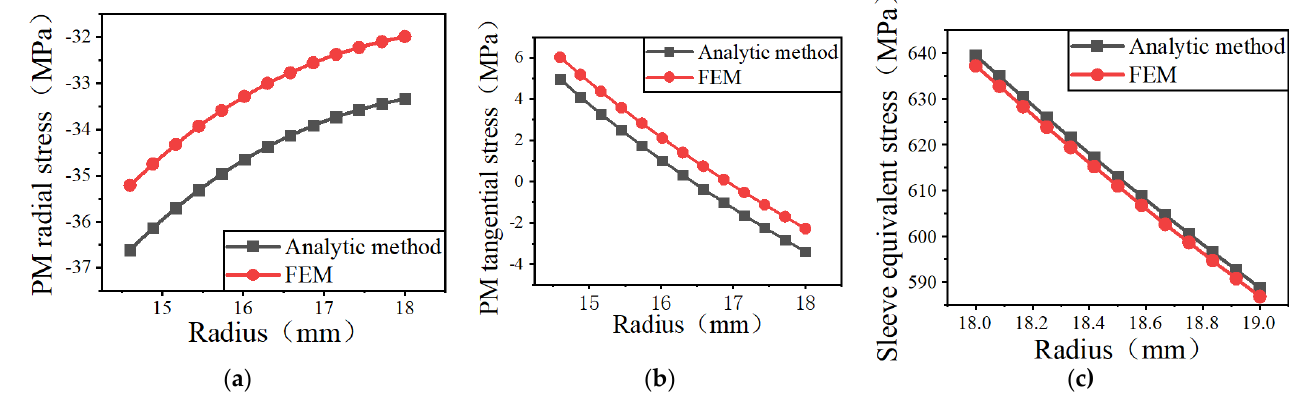
Figure 19. Stress distribution of the sleeve–PM–core–shaft structure rotor. ( a ) PM radial stress; ( b ) PM tangential stress; ( c ) sleeve equivalent stress.